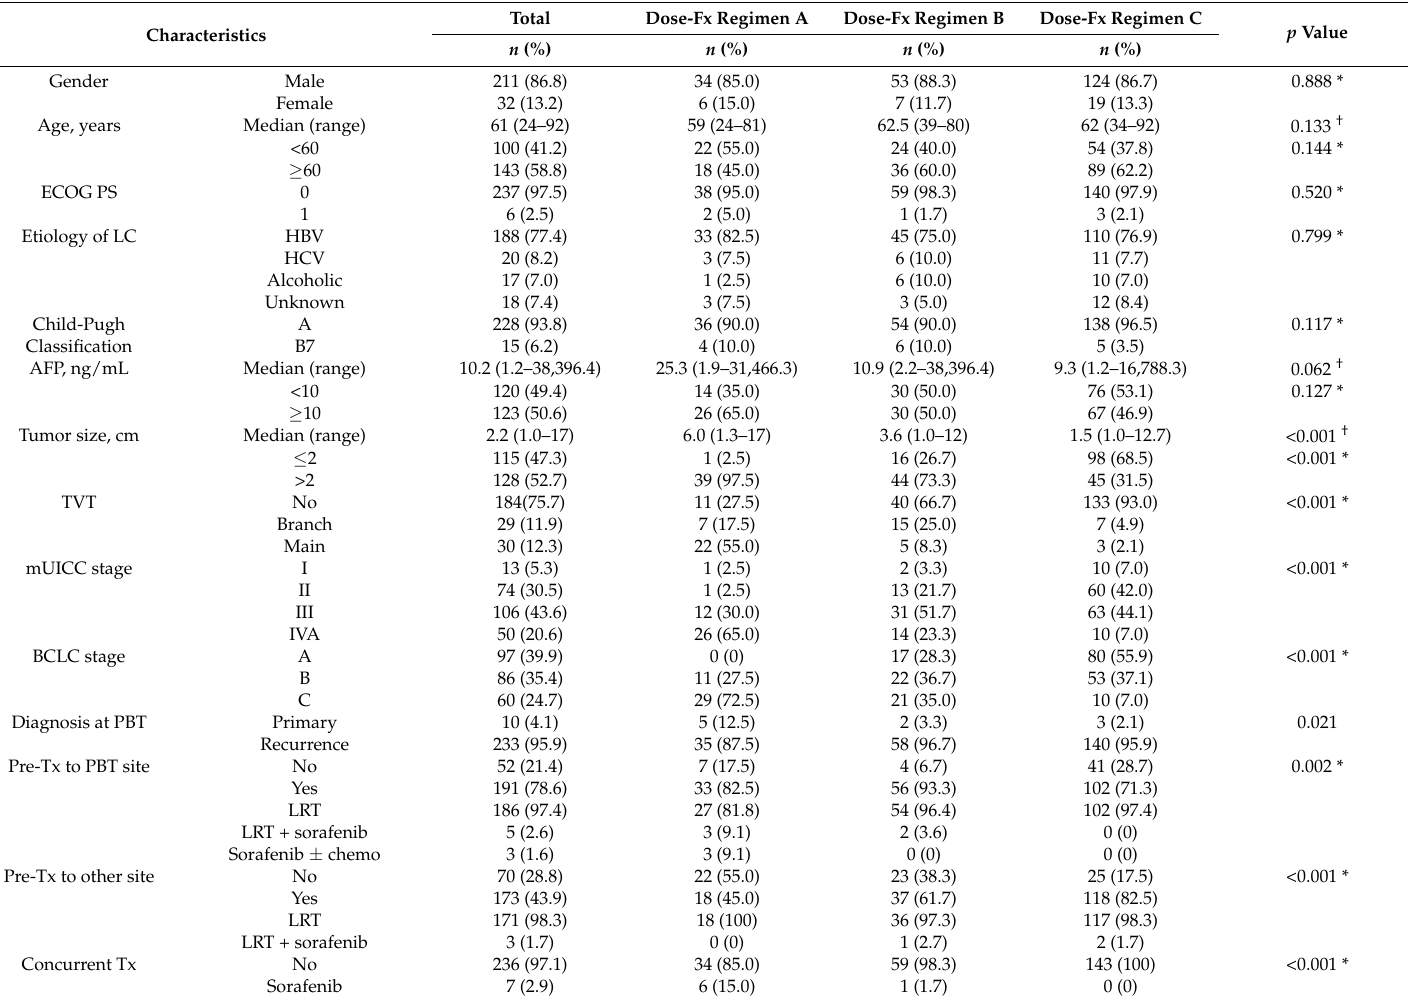
Table 1. Patient characteristics in all patients and subgroups according to dose-fractionation (Dose-Fx) regimens.